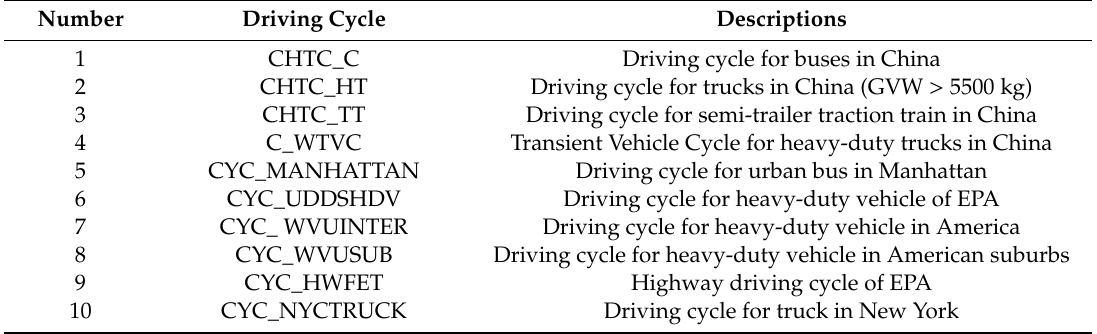
Table 2. Sample database of driving cycles for hybrid heavy-duty